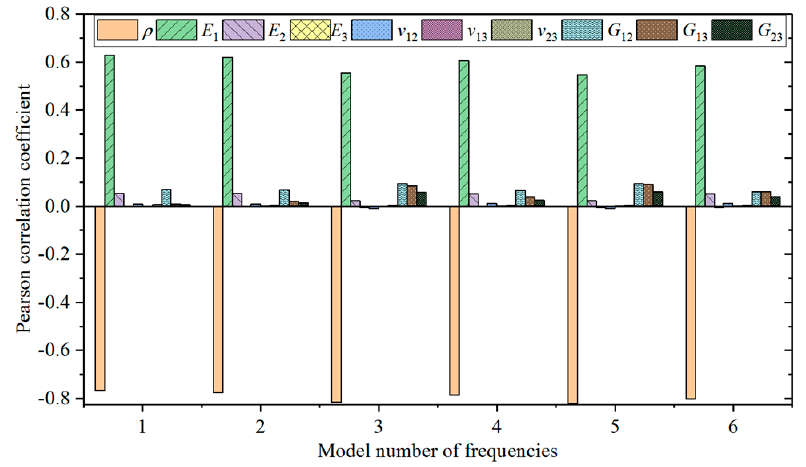
Figure 7. Pearson correlation factors of the CFRP material parameters.